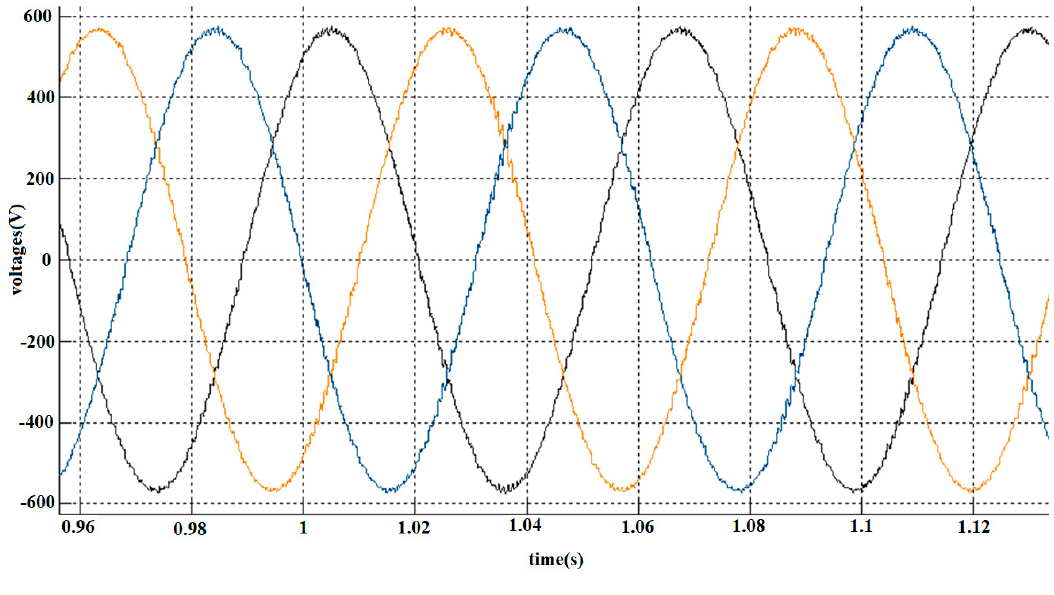
Figure 23. Output voltage waveform of wind farm.